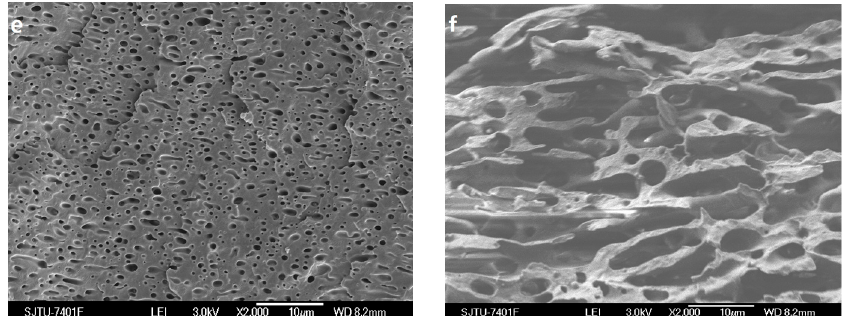
Figure 11. SEM images showing the fracture surfaces of ( a ) LCB PP/PEOc-80/20; ( b ) LCB PP/PEOc- 60/40; ( c ) LCB PP/PEOc-40/60; ( d ) iPP/PEOc-80/20; ( e ) iPP/PEOc-60/40 and ( f ) iPP/PEOc-40/60 blends (etched by xylene at room